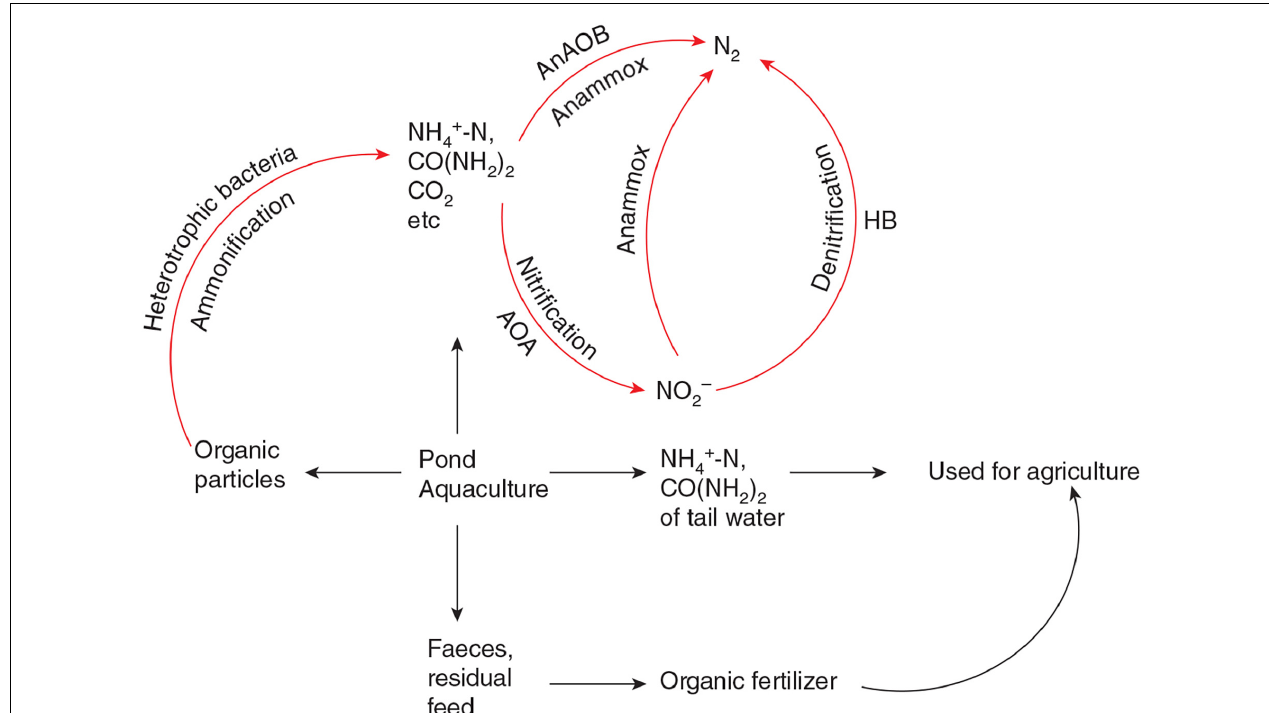
FIGURE 2 | Schematic diagram of a pond aquaculture water treatment process to be established in the future. AOA, ammonia-oxidizing archaea; AnAOB, anaerobic ammonia-oxidizing bacteria; HB, heterotrophic denitrifying bacteria. Red arrows represent different nitrogen cycling processes in the pond aquaculture water treatment process. Black arrows represent the flow direction of pond organic matter rich in nitrogen. Feces and residual feed are further processed and become agricultural organic fertilizer. Part of pond aquaculture tail water rich in NH 4 + and CO(NH 2 ) 2 can be directly used for agricultural irrigation. Most NH 4 + and CO(NH 2 ) 2 are directly generated by aquaculture animals or arise from ammonification by heterotrophic bacteria mainly removed via nitrification and anammox by AOA and AnAOB.